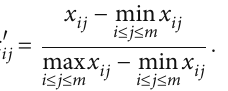
Figure 1: Standardization fl ow chart of teaching evaluation data fi